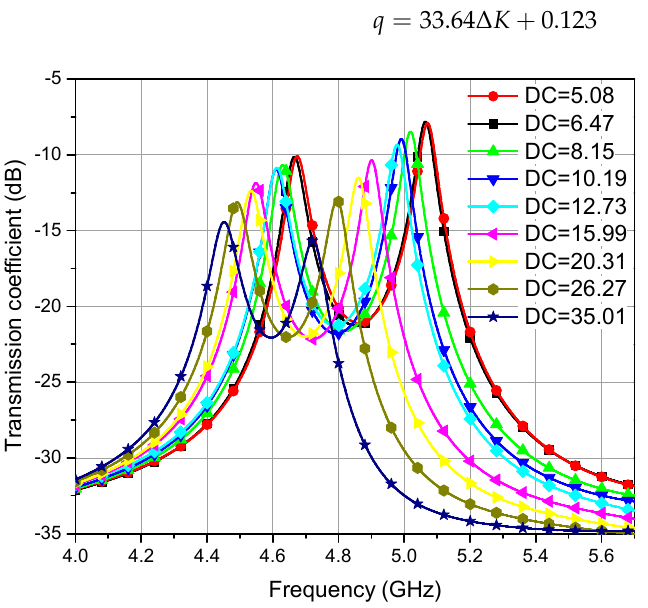
Figure 8. Measured response of ethanol – distilled water solution, with frequency vs. S21 for different concentrations of solutions.